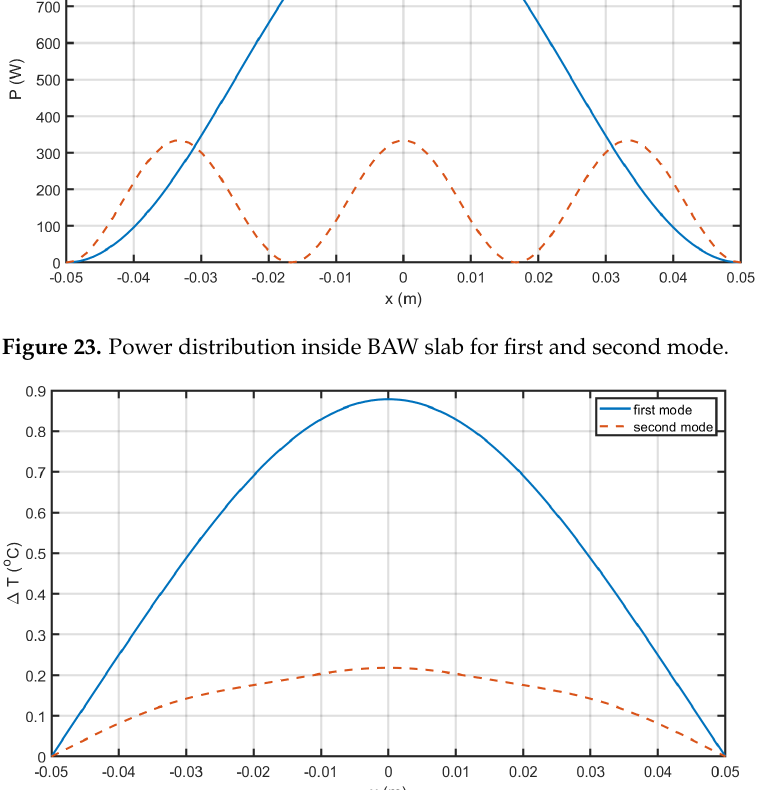
Figure 24. Temperature distribution inside BAW slab for first and second